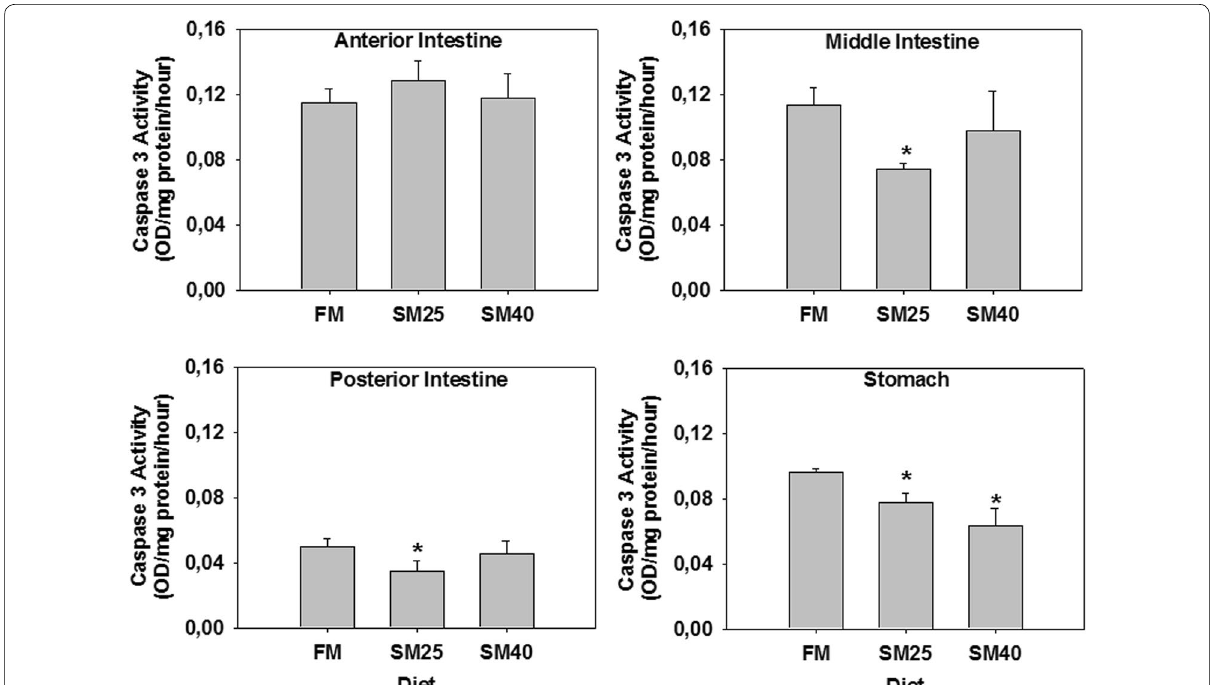
Fig. 4 Caspase-3 activity in the anterior, middle, posterior intestine and stomach of common dentex ( D. dentex ) under the FM, SM25 and SM40 diet treatment. Values represent mean SD for at least three independent experiments; n ± to FM